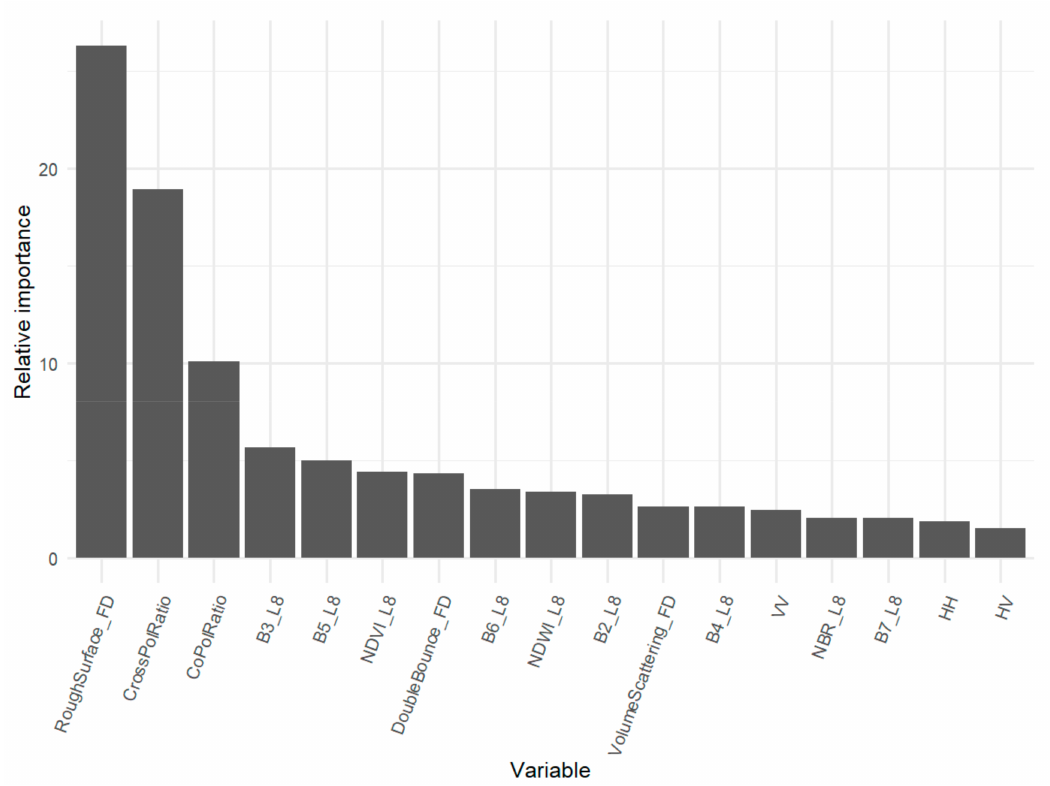
Figure 3. The relative importance of inputs in the prediction